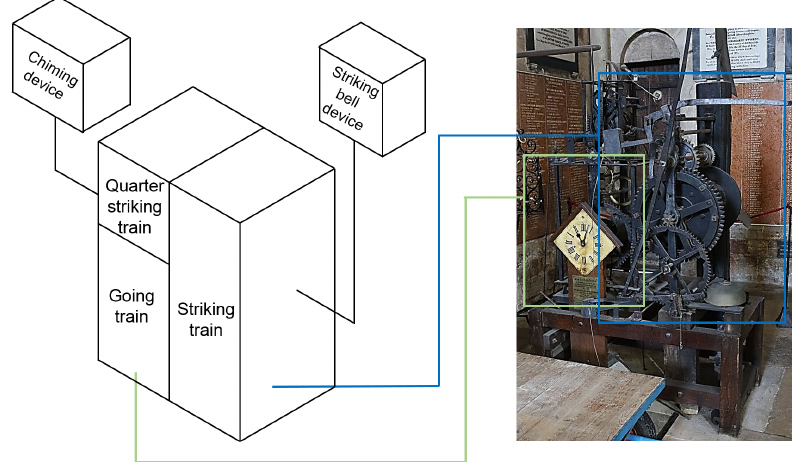
Figure 7. Structure of the Exeter clock (N1) (Rabbott,